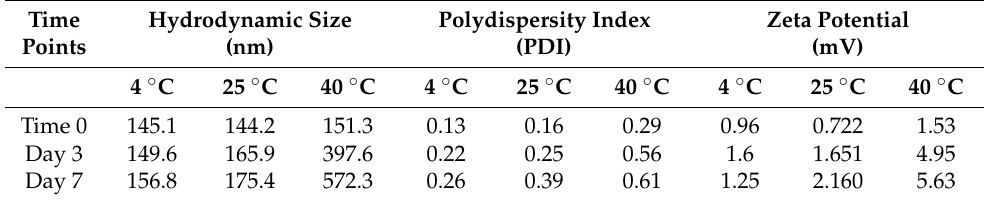
Table 4. HA − PTX + RTV − NMF -accelerated temperature stability study.